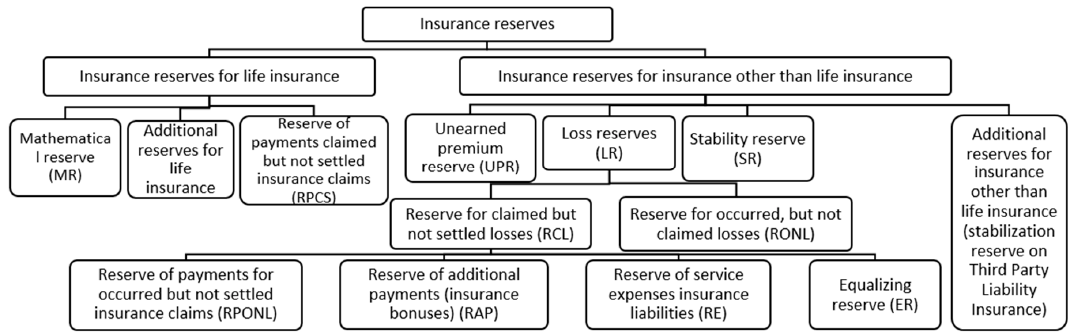
Figure 5. The composition of insurance reserves. Developed based on Orlanuk-Malickaya and Janova (2012).